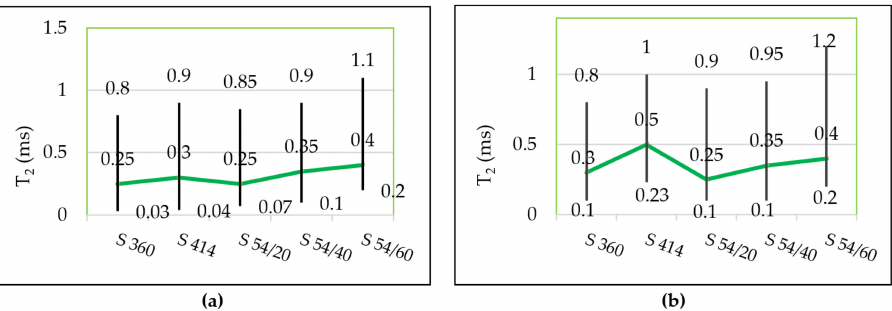
Figure 6. The distribution range of the gel pores for: ( a ) the control samples; ( b ) for samples subjected to freeze–thaw cycles. Both measurements are performed on water-saturated samples.